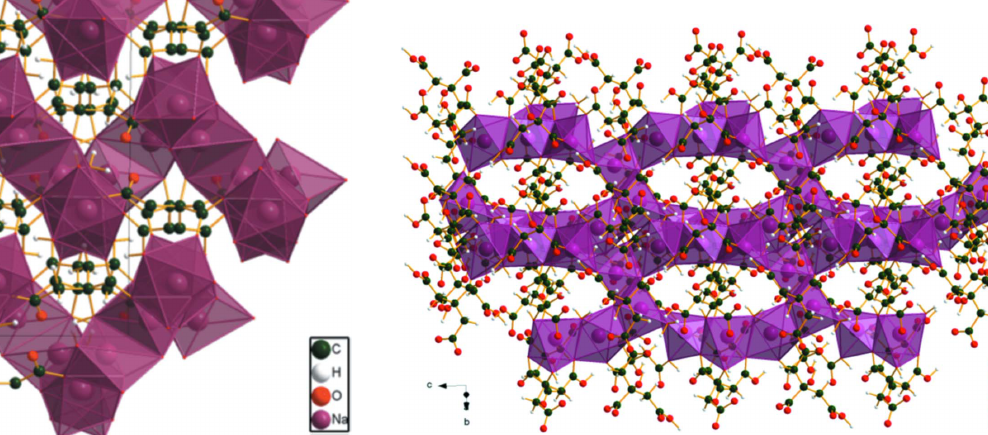
Figure 7 View of the crystal structure of (I), viewed down